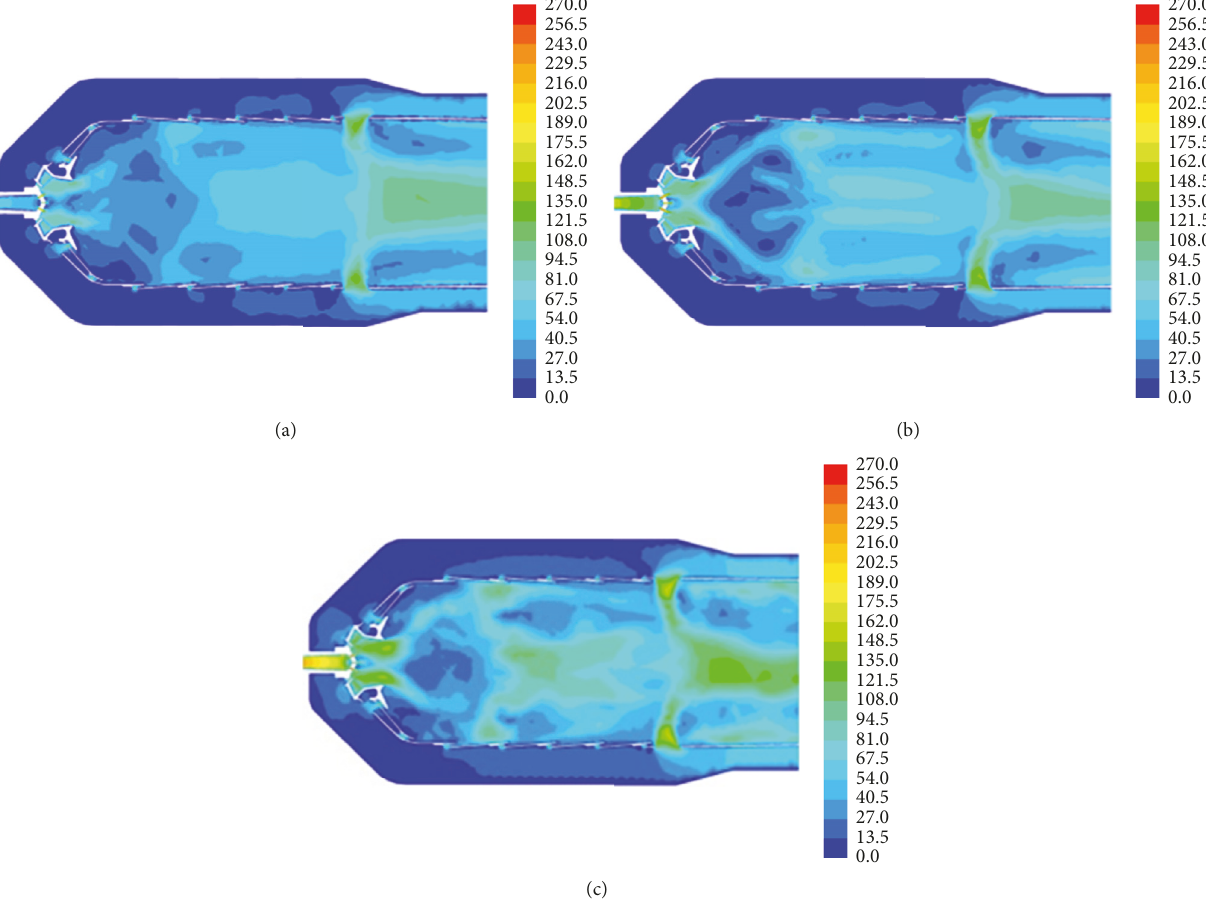
Figure 5: Distribution of the velocity in the longitudinal section of the combustor, m/s: (a) variant 1; (b) variant 2; (c) variant 3.